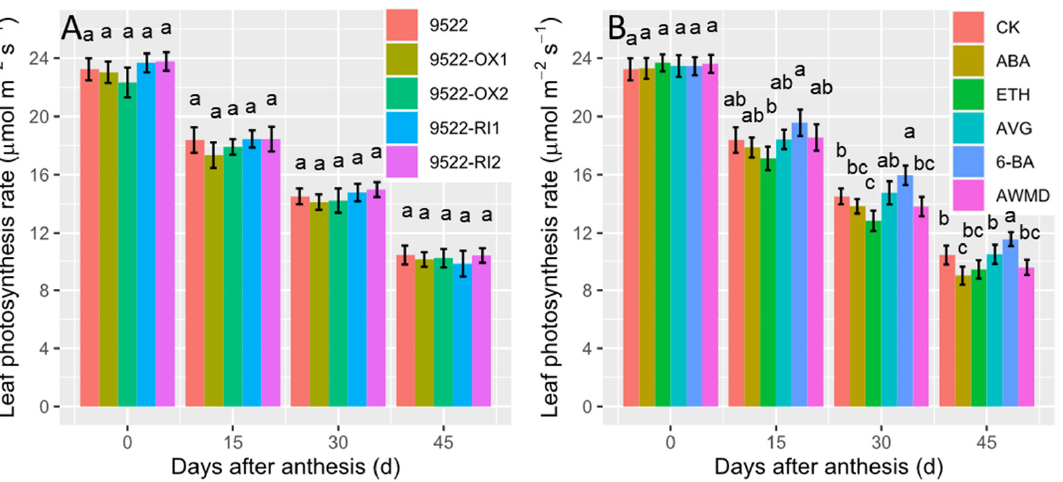
Figure 4. Changes in flag leaf photosynthesis rates of wildtype and transgenic lines ( A ), and application of exogenous phytohormone/alternate wetting and under moderate drying (AWMD) irrigation ( B ) during grain filling (0–45 days after anthesis). Symbols and significance levels are as described in Figure 1.